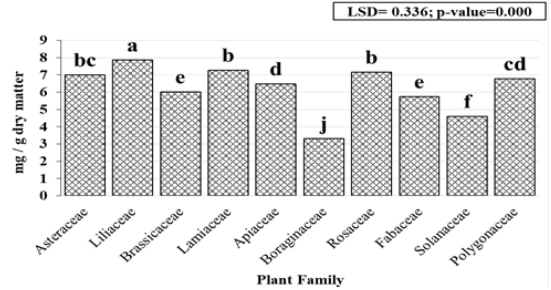
Fig. 7. The antioxidant capacity of plant family regardless of plant species by TAC method (mg / g dry matter equivalent to mg ascorbic acid /dry matter).